Question: In a single sentence, describe what this figure presents.
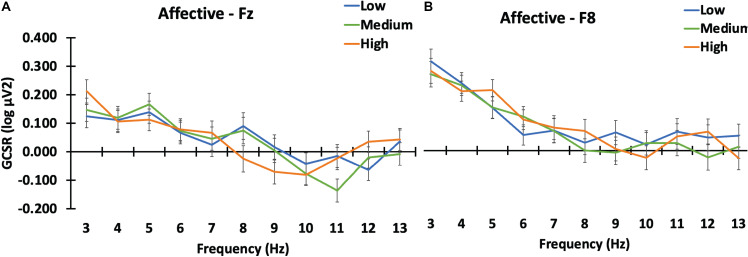
Answer: EEG power of affective groups on GCSR at Fz and F8. Note: The Y axis represents the EEG power (log µV 2 ) for the GIS (GCSR) measure. Affective groups are: low (blue); medium (green; and high (orange). The X-axis is the frequency (Hz). A . Findings at Fz. B . findings at F8. Error bars represent standard error.